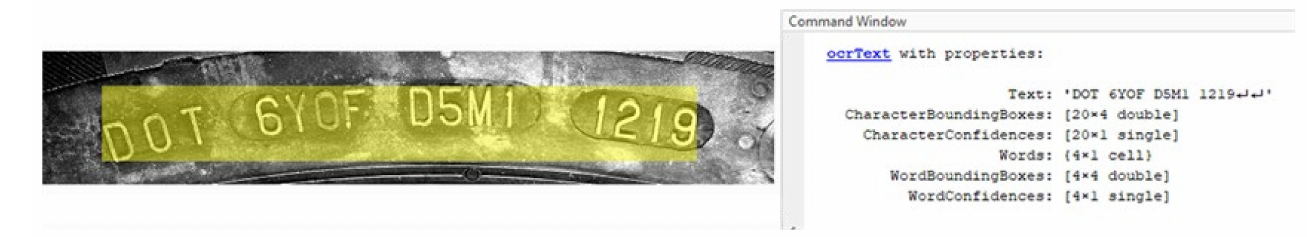
Figure 9. Result of verification process via optical character recognition (OCR)